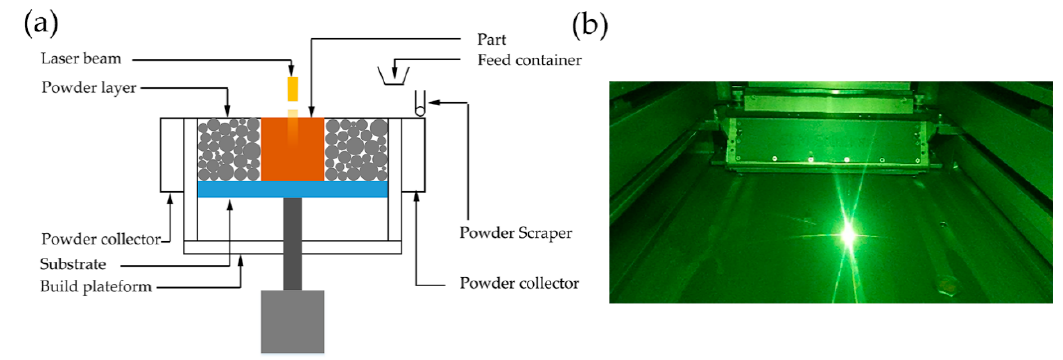
Figure 1. ( a ) Schematic diagram of selective laser melting (SLM) equipment; ( b ) the building process of the SLM.